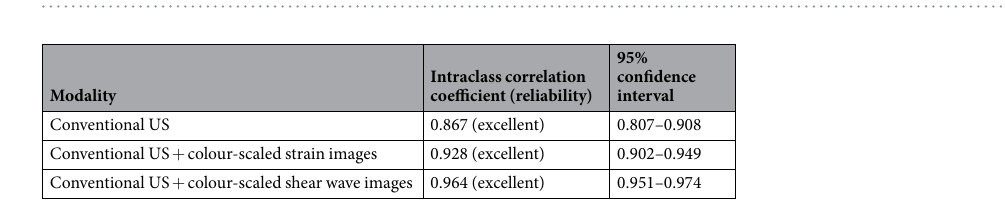
Table 2. Interobserver agreement of visual score grading by strain and shear wave elastography and the Breast Imaging Reporting and Data System categorization.